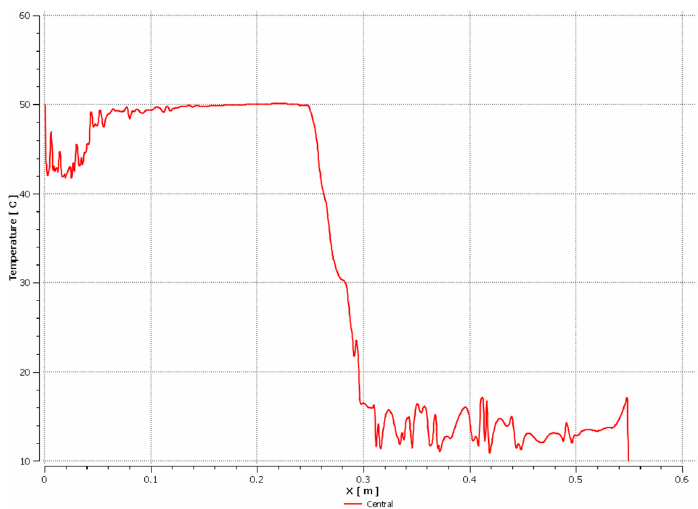
Figure 31. Temperature distribution along the height of the heat pipe’s